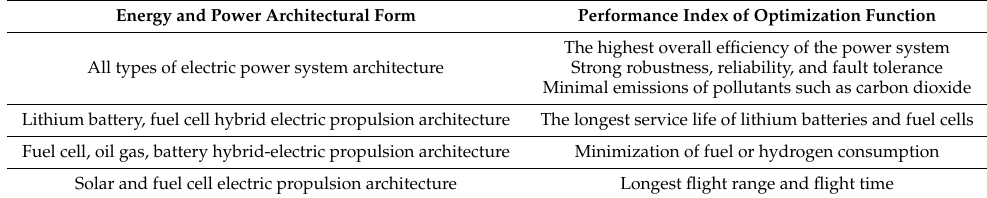
Table 1. Optimization index of different electric power